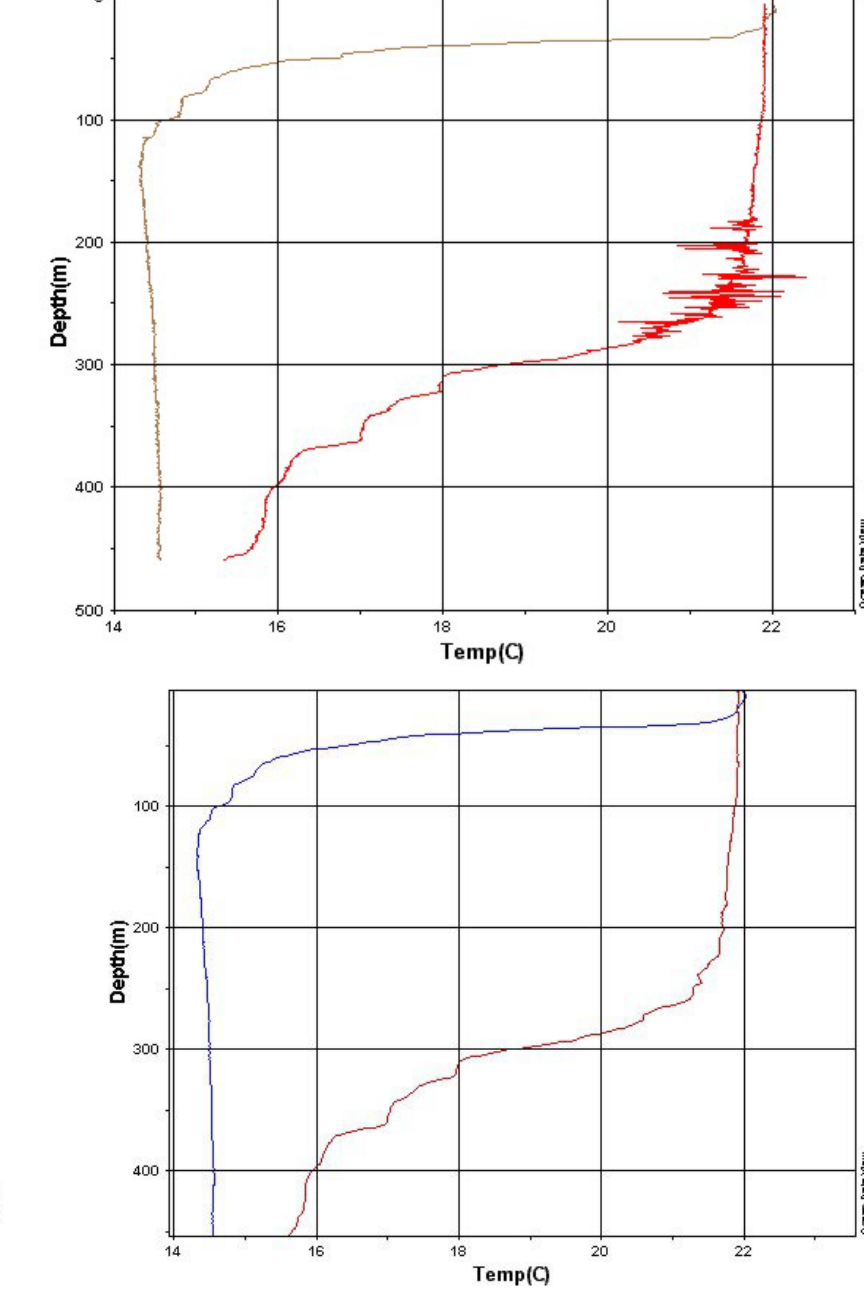
precise, it does not introduce errors in the numerical